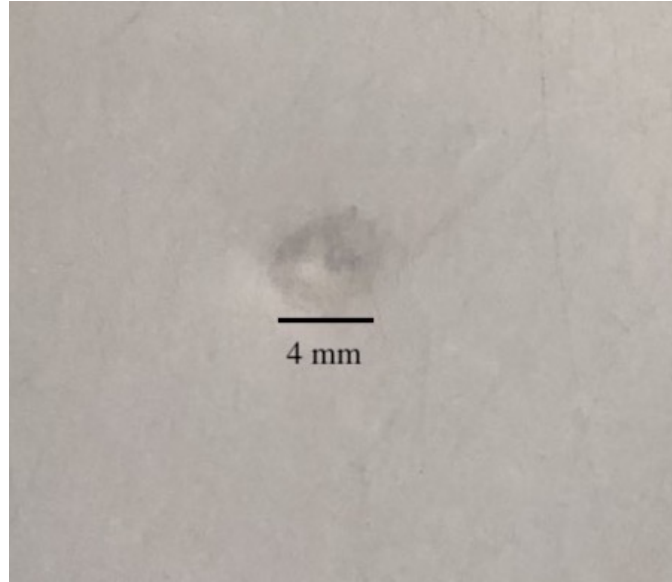
Figure 1. Impact of a hard projectile on a metallic panel, illustrating the importance of an improved dent resistance, in terms of the aesthetics of the product. The impact if highly localised compared to the size of the outer panel.